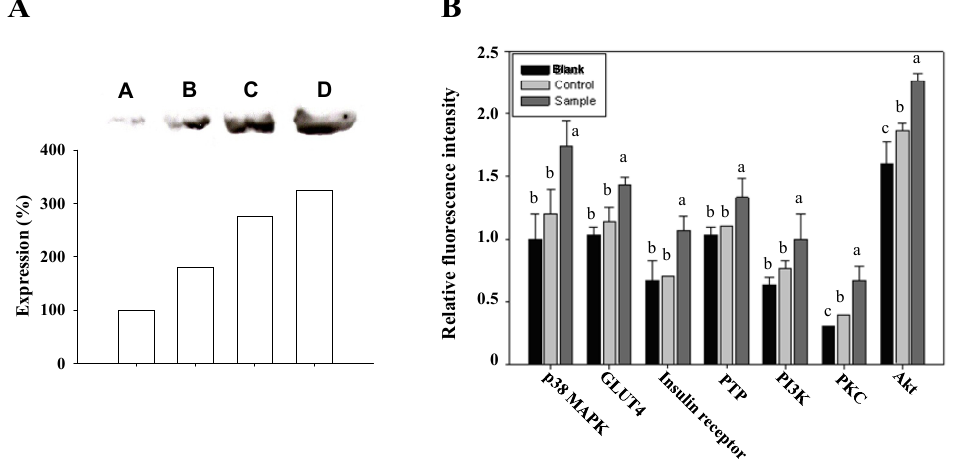
Figure 4. Effect of S. pastorianus extract on the GLUT 4, PTP, insulin receptor, and signal transduction protein expression in 3T3-L1 cells. ( A ) GLUT4 Western blot of cell membrane preparation of treated 3T3-L1 cells. Histogram representing the densitometric analysis. A: control; B: S. pastorianus extract; C: Insulin; D: Insulin + S. pastorianus extract. GLUT4 expression percentage was relative to control, where control was considered as 100% expression. ( B ) Effect of S. pastorianus extract on the expression of PTP and insulin receptor in cell membrane and some signal transduction proteins in the cytosol of differentiated 3T3-L1 cells evaluated by flow cytometry analysis as described in Materials and Methods. Blank: cells treated with glucose alone; Control: cells treated with glucose and insulin; Sample: cells treated with glucose, insulin, and S. pastorianus extract. Data represent means ± SD (n = 3). Different letters (a, b, c) on the bars are significantly different in each group ( p <